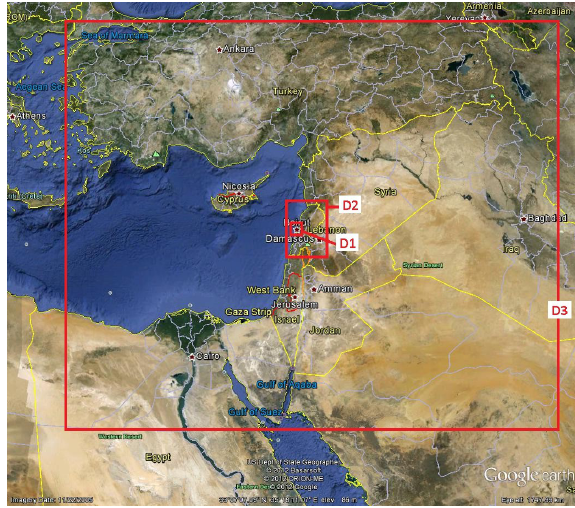
Figure 1. The modeling domains D1, D2 and D3 used in this study. 3 Fig. 1. The modeling domains D1, D2 and D3 used in this